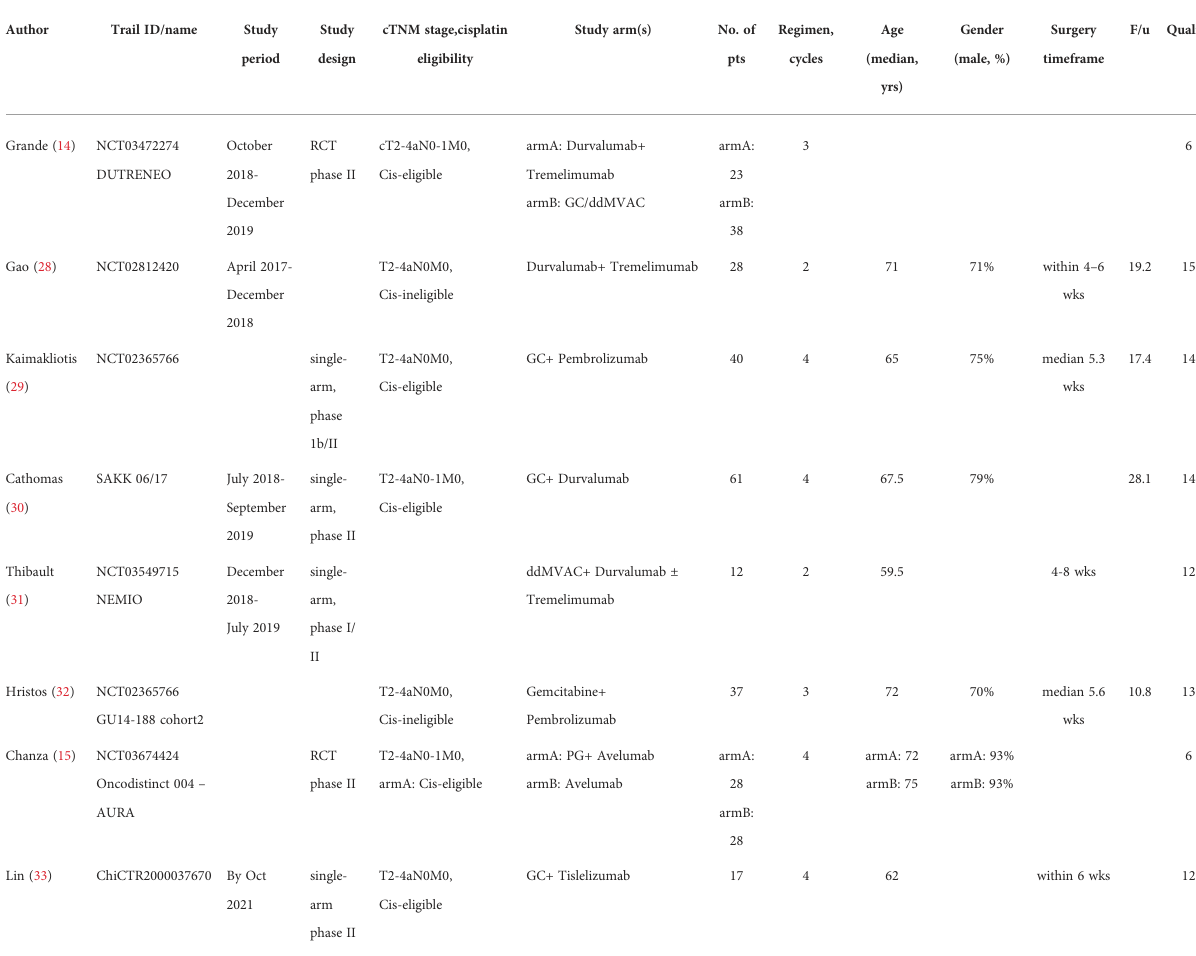
16.9%, Figure 4A) and 75.6% (95% CI: 55.4%-95.8%, Figure 4E), respectively. In subgroup analysis, the pooled Grade ≥ 3 irAEs rate for ICI monotherapy, dual-ICIs therapy, and GC plus ICI therapy was 7.4% (95% CI: 4.3%-10.5%, Figure 4B), 30.3% (95% CI: 15.3%-45.3%, Figure 4C), and 14.5% (95% CI: 3.5% - 25.4%, Figure 4D), respectively. To control the irAEs, the systemic steroid was required for two, four, and four patients in the studies by Funt et al. Necchi et al., and Gao et al, respectively (20, 25, 28). Only the ABACUS study reported one treatment- related death (16). further extracted the Grade ≥ 3 TRAEs in patients receiving chemoimmunotherapy. The pooled morbidity was 32.4% (95% CI: 13.1% - 51.6%, Figure 4F). The hematological disorder was the most common Grade ≥ 3 TRAEs, with morbidity of